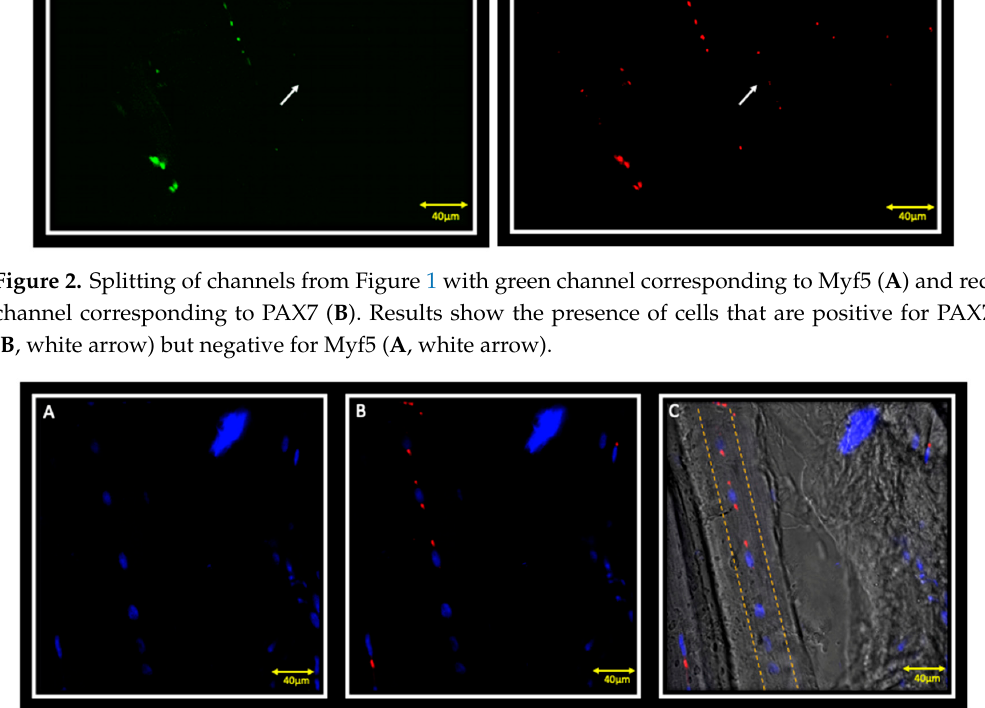
Figure 2. Splitting of channels from Figure 1 with green channel corresponding to Myf5 ( A ) and red channel corresponding to PAX7 ( B ). Results show the presence of cells that are positive for PAX7 ( B , white arrow) but negative for Myf5 ( A , white arrow).